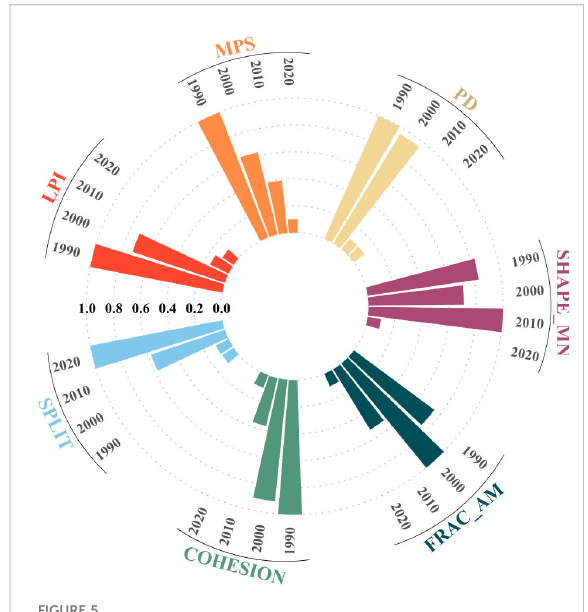
FIGURE 5 Landscape characteristics (normalized) of tidal fl ats from 1990 to 2020 (LPI, largest patch index; PD, patch density; MPS, mean patch area distribution; SHAPE_MN, mean shape index; FRAC_AM, area-weighted mean patch fractal dimension; COHESION, patch cohesion index; SPLIT, splitting